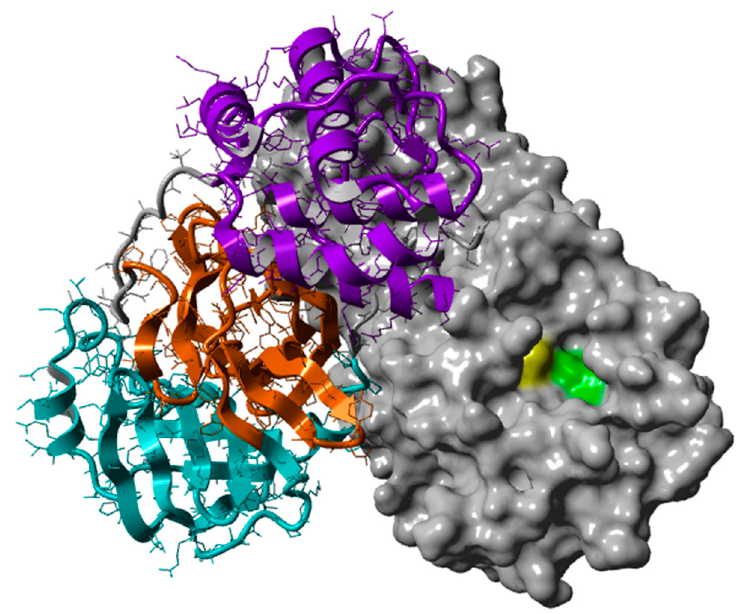
Figure 1. SARS-CoV-2 M pro in the active form of a homodimer (PDB ID: 7JKV). The three domains and their secondary structure are visible in the left monomer (domain I is in cyan, domain II in orange, and domain III in purple). The right monomer is shown as surface, with the catalytic residues His41 and Cys145 being highlighted in green and yellow, respectively.